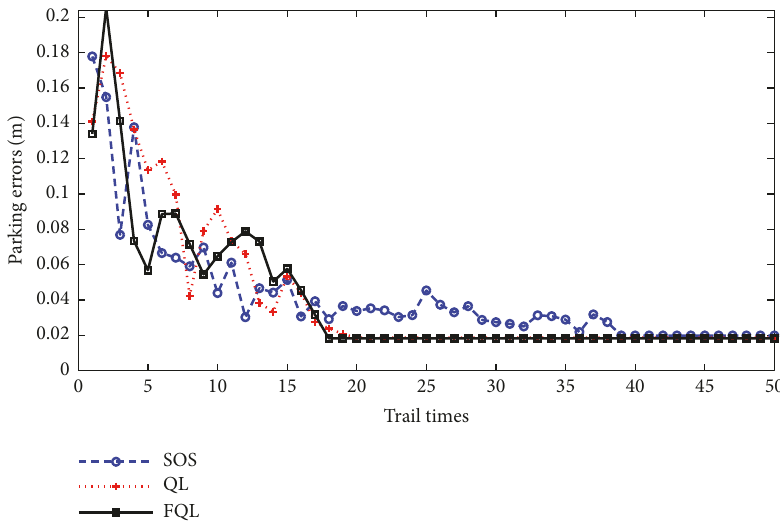
Figure 6: 50 trials of three algorithms about 10 different initial speeds.